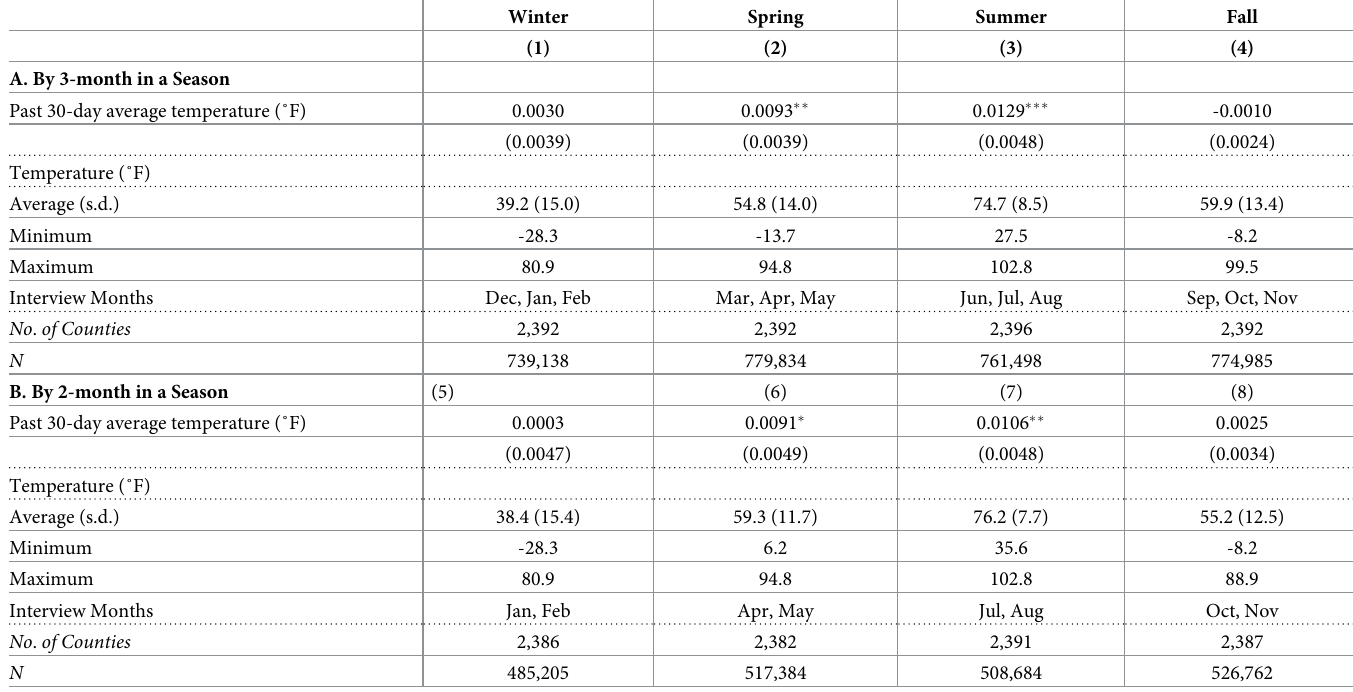
Table 5. Effect of temperature over previous 30 days on the probability of self-reported mental health difficulties: By season. Winter Spring Summer Fall (1) (2) (3)